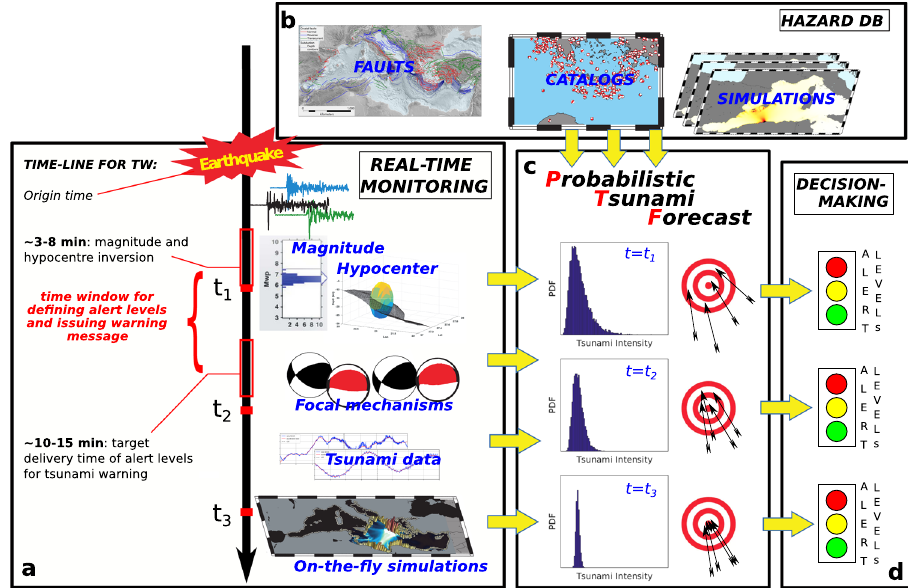
Fig. 1 PTF concept. a Timeline for tsunami warning: real-time information from an earthquake that just occurred and from the ongoing tsunami gradually integrates b local long-term hazard information, c progressively increasing the precision of the probabilistic forecasts (hazard curves) produced by the Probabilistic Tsunami Forecasting (PTF). d At any time, PTF can be transformed into alert levels (here represented as traf fi c lights) useful for decision making. In the current study, implementation refers to the time t 1 , when only earthquake magnitude and hypocentre estimates are available from real-time